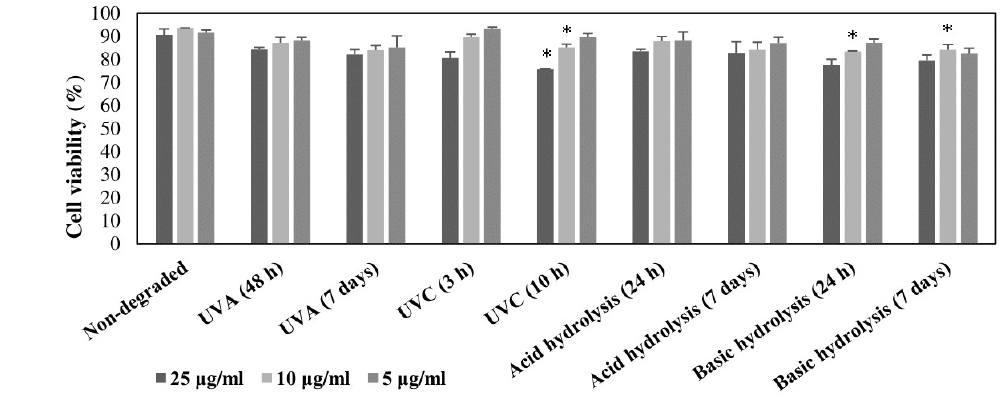
FIGURE 4 – Mean cell viabilities (%) of degraded samples analyzed in two different times and three concentrations, using 3T3 cells and MTT assay. *significant response compared to the respective non-degraded sample